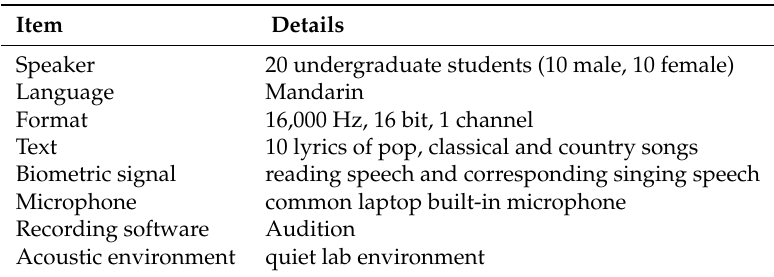
Table 1. RSS corpus